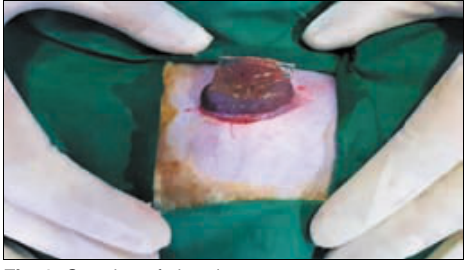
Fig. 2. Creation of abrasion